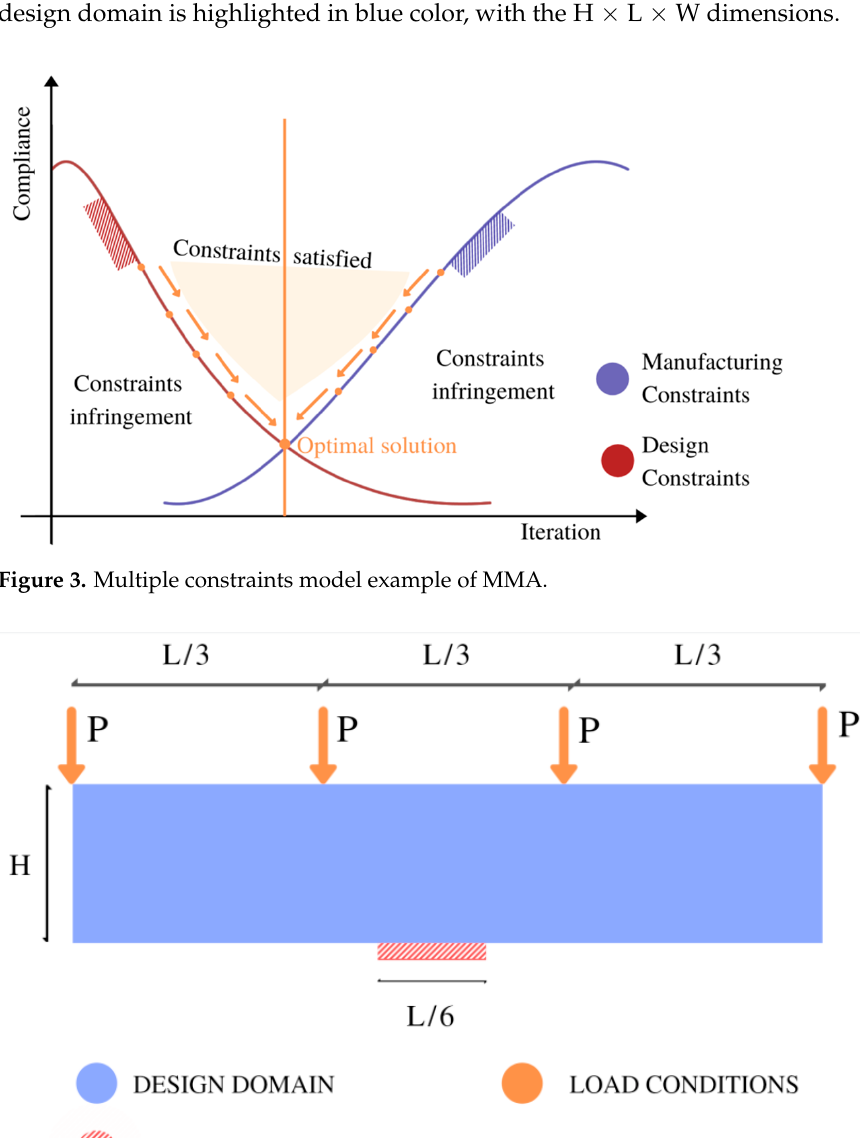
Figure 4. Field of the design domain with displacement and prescribed load